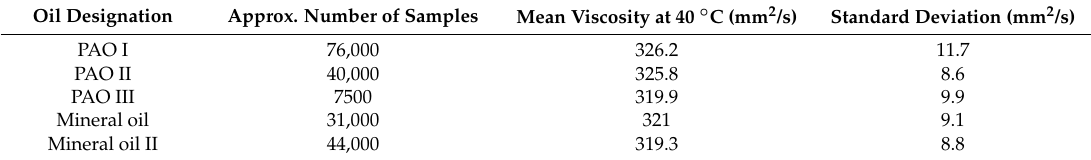
Table 9. Mean and standard deviation of the viscosity at 40 ◦ C from a database of oil samples.